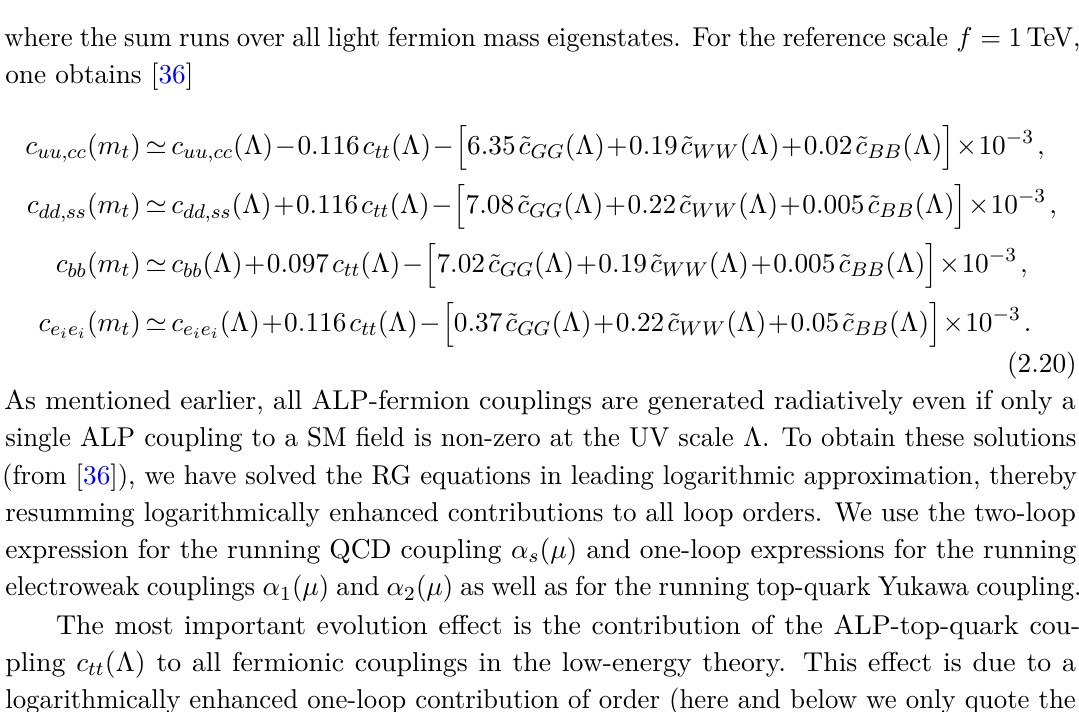
contribution to c GG e i e i